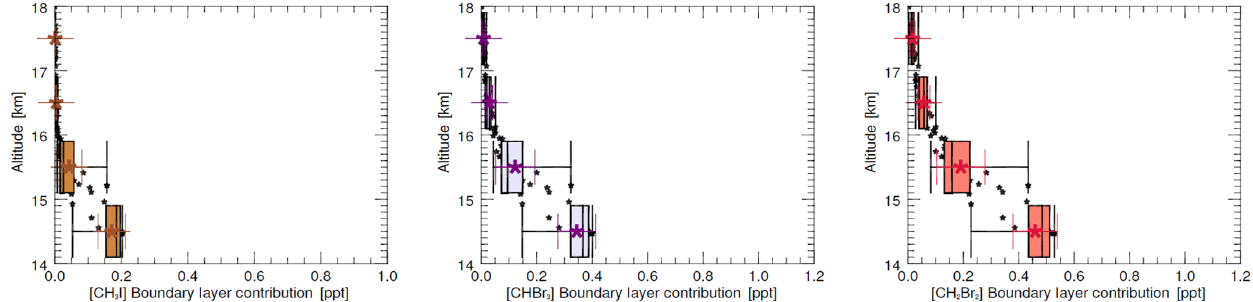
Figure 4. NAME-modelled CH 3 I, CHBr 3 and CH 2 Br 2 boundary layer contribution to the TTL, research flight 02, ATTREX